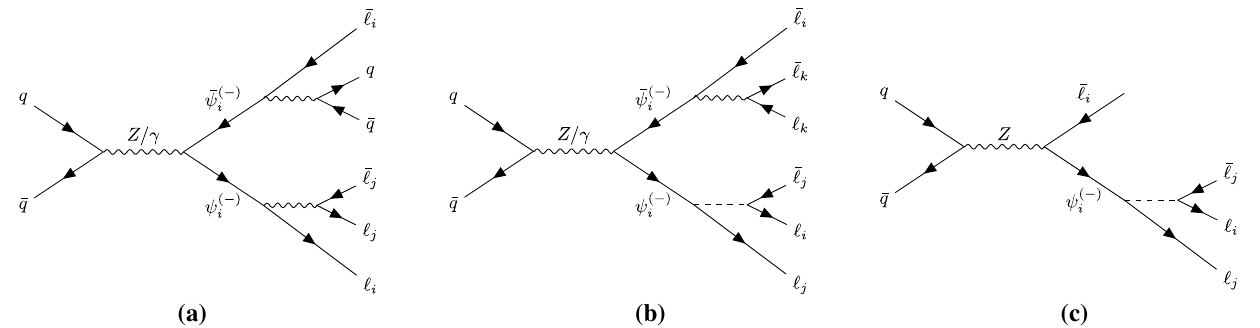
tribute via the diagram with jets in the final state ( a ) and the single production diagram ( c ), while all generations can contribute to